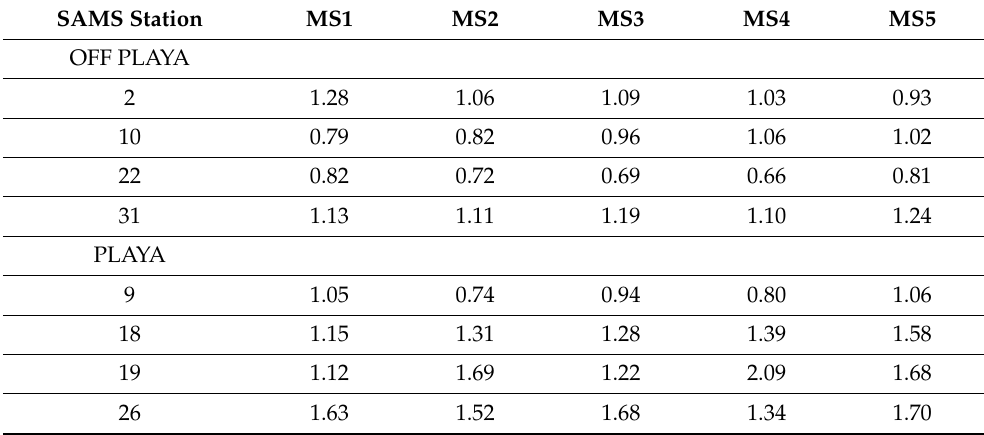
Table 7. Aggregate 10 m AGL v-wind component mean absolute error values for each model